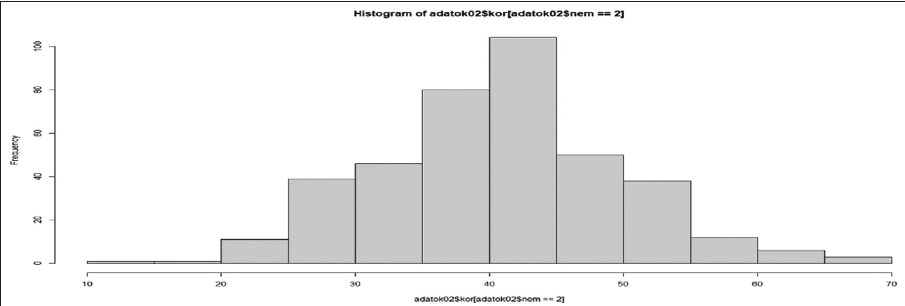
FIGURE 3. The age distribution of all women measured under the investigation (X-axis shows the age groups of 10-70 years, Y-axis shows the size of the number of elements/person).